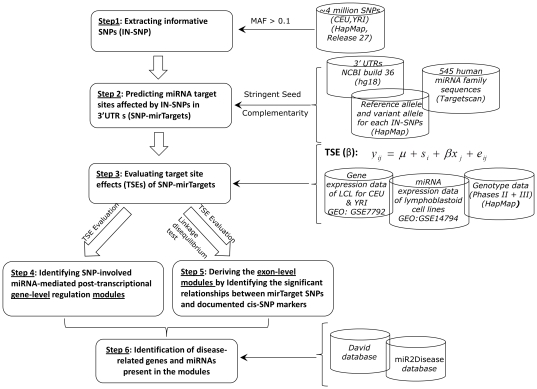
The schematic presentation of the study flow.